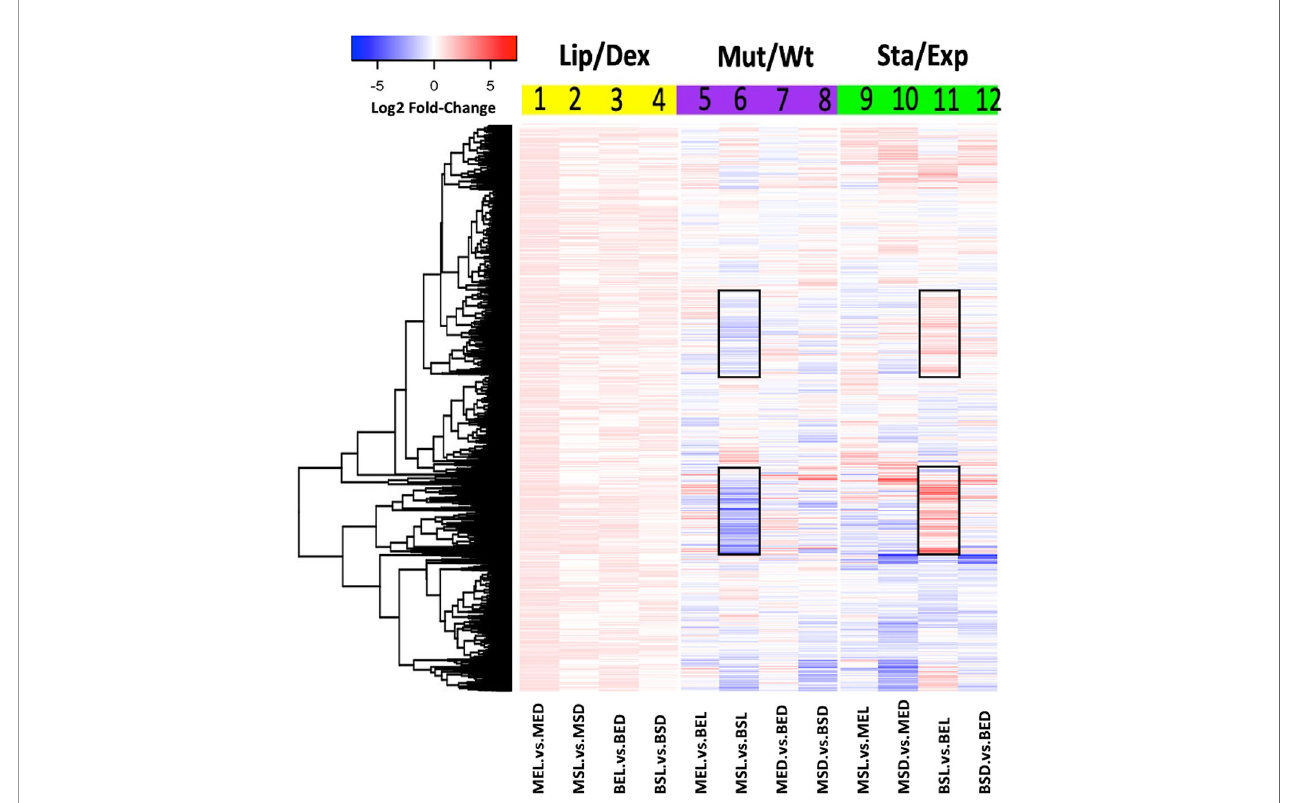
FIGURE 2 | Global transcriptomic expression of M. bovis BCG genes. Heat map showed the log2 fold-change values of each gene expression under three different analyses: lipid effect (yellow block), BCG_2177c mutation effect (purple block), and growth phase effect (green block). All experiments were performed as previously described in the methodology section. wtBCG or mtBCG strains cultured in dextrose or lipids during the exponential (BED, wtBCG dextrose; BEL, wtBCG lipids; MED, mtBCG dextrose; MEL, mtBCG lipids) or stationary phase (BSD, wtBCG dextrose; BSL, wtBCG lipids; MSD, mtBCG dextrose; MSL, mtBCG